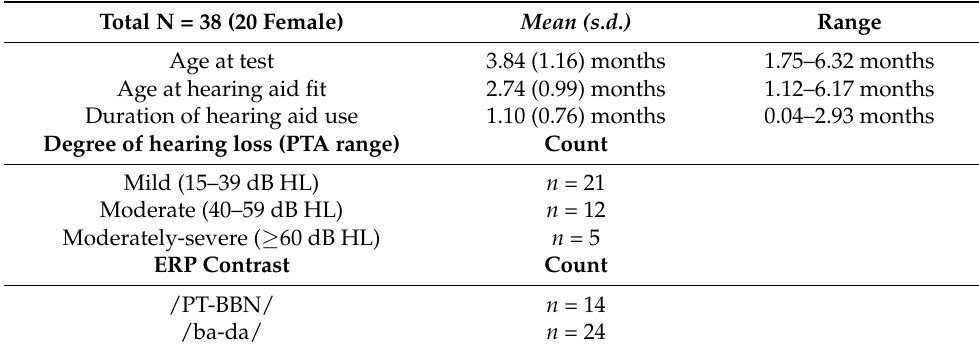
Table 1. Summary of participant